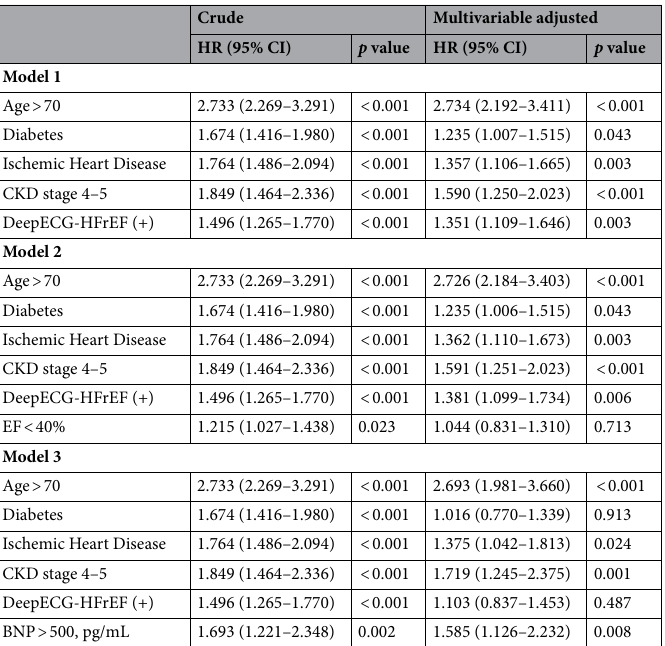
Table 3. Crude and adjusted hazard ratio for 5-year all-cause mortality among 1291 of heart failure ECGs. BNP B-type natriuretic peptide, CI confidence interval, CKD chronic kidney disease, ECG electrocardiogram, EF ejection fraction, HR hazard